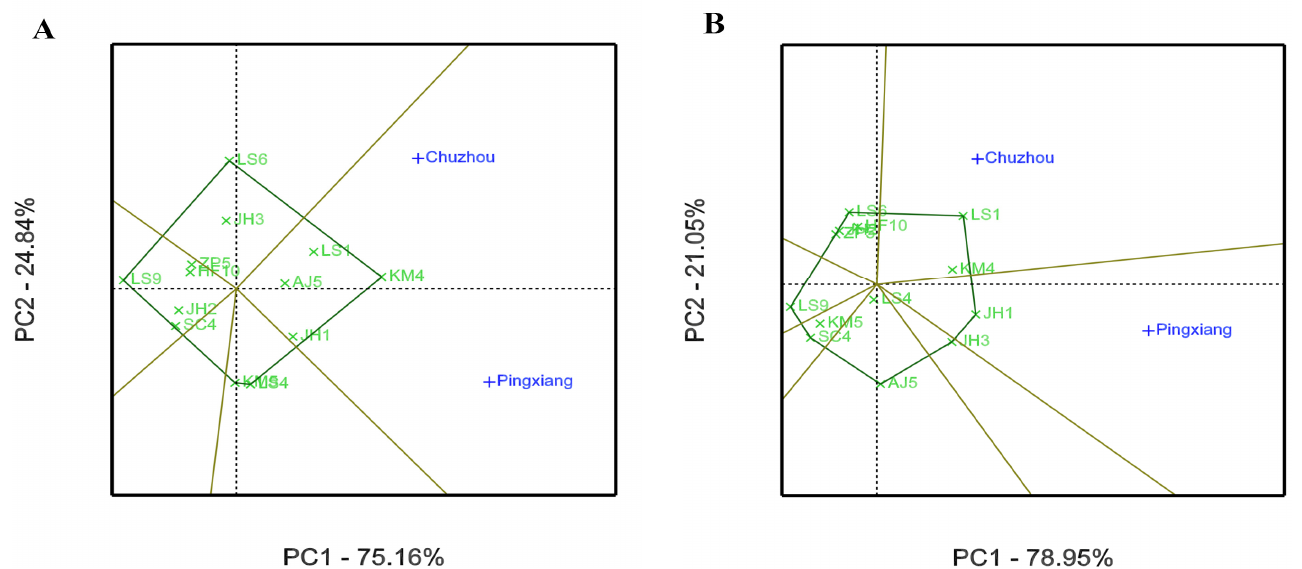
Figure 3. Polygon views of the GGE biplot based on symmetrical scaling for the which-won-where pattern for C. paliurus genotypes evaluated for tree height ( A ) and diameter at breast height ( B ).